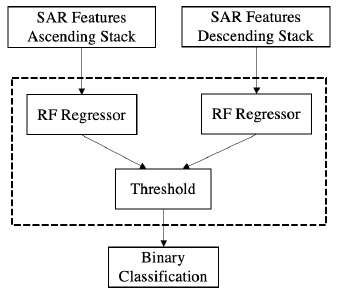
Figure 4: Binary classifier block diagram.